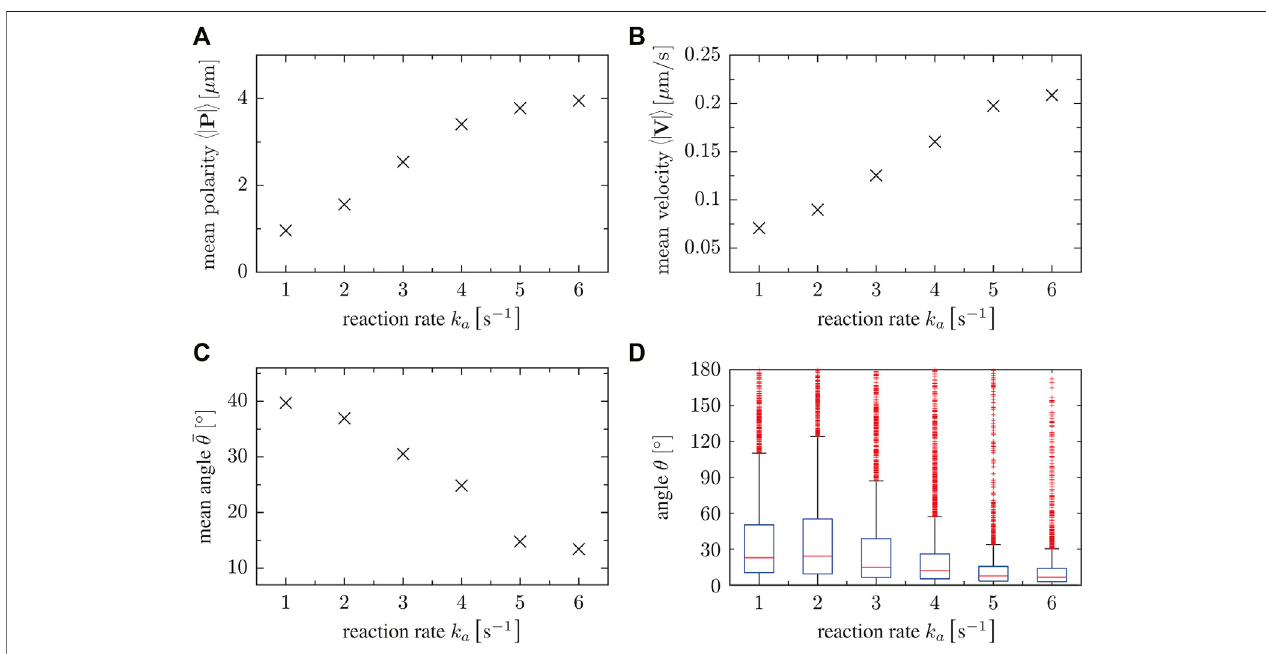
FIGURE4|(A) Magnitude ofmean polarity 〈 | P | 〉 , (B) meanvelocity 〈 | V | 〉 and (C) the meanangle for differentvalues ofthe reaction rateparameter k a .Accordingly, this parameter controls the polarity ofsingle cells. (D) Box plots of the angle θ as a function of the reaction rate parameter k a . For high k a , velocity and cell polarity tend to be